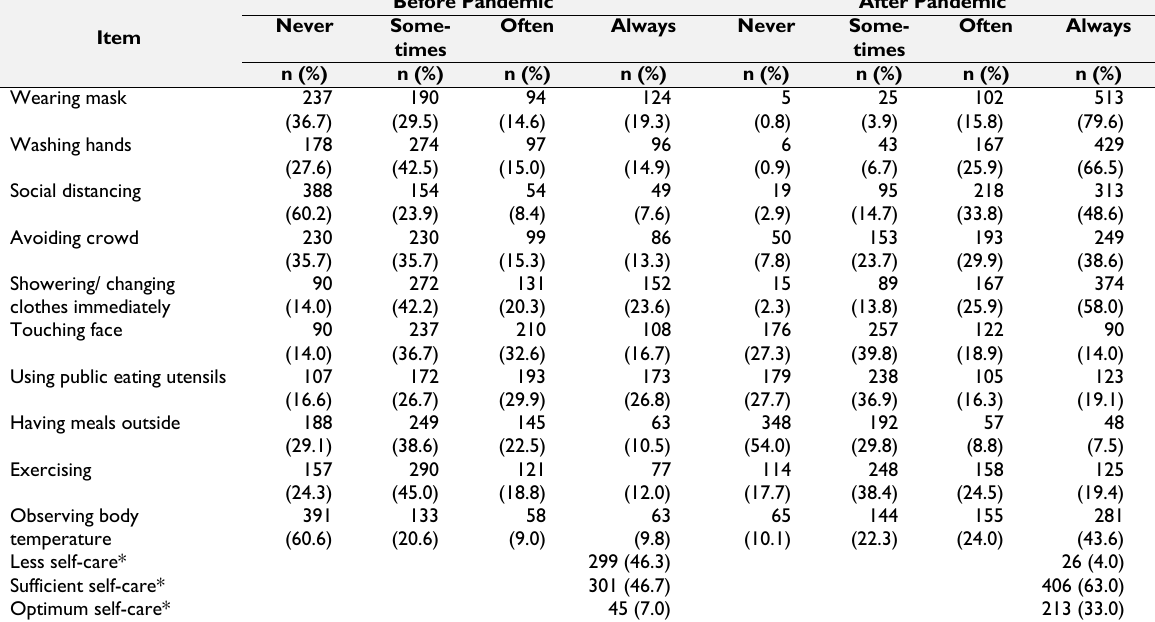
Table 2 Self-care activities before and after pandemic